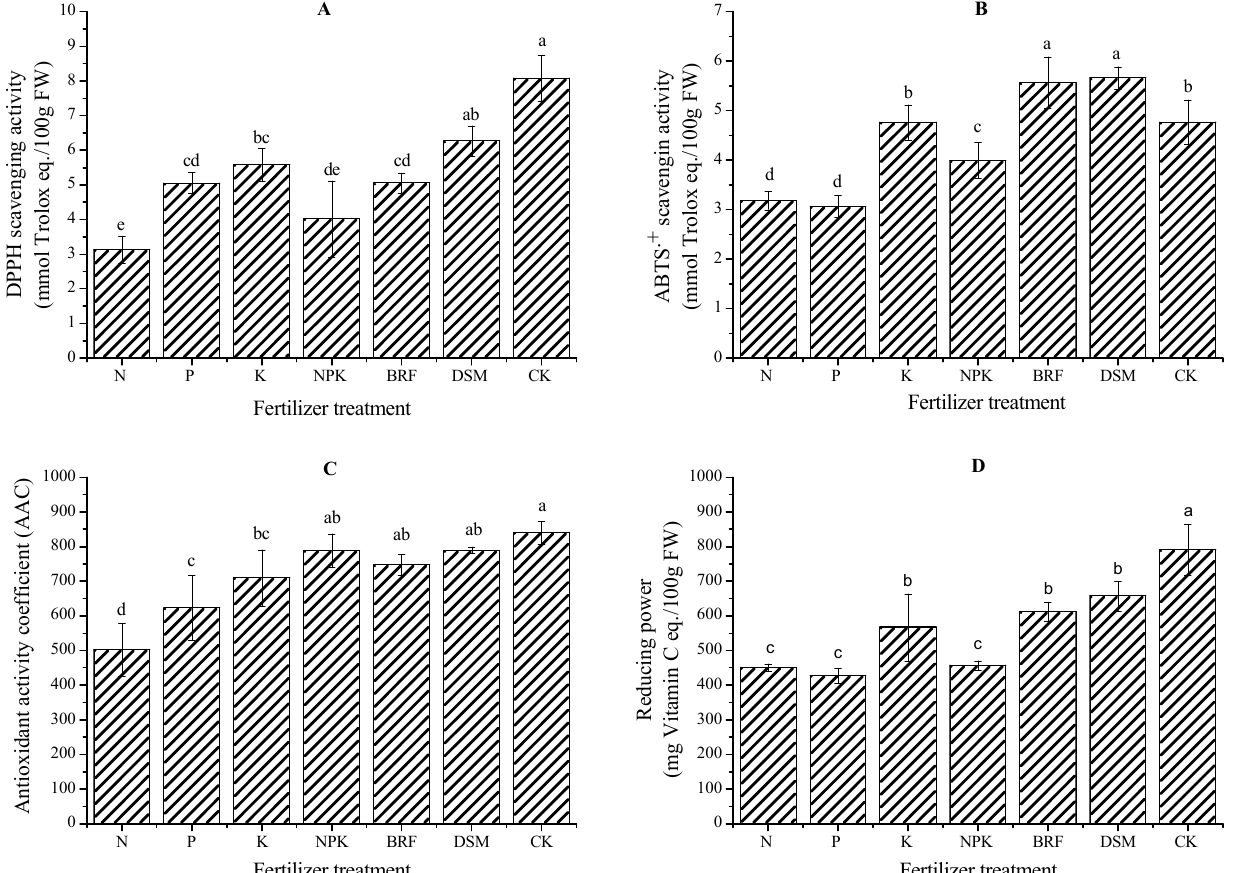
Figure 2. The antioxidant activity of jujube fruit produced by different fertilizers.